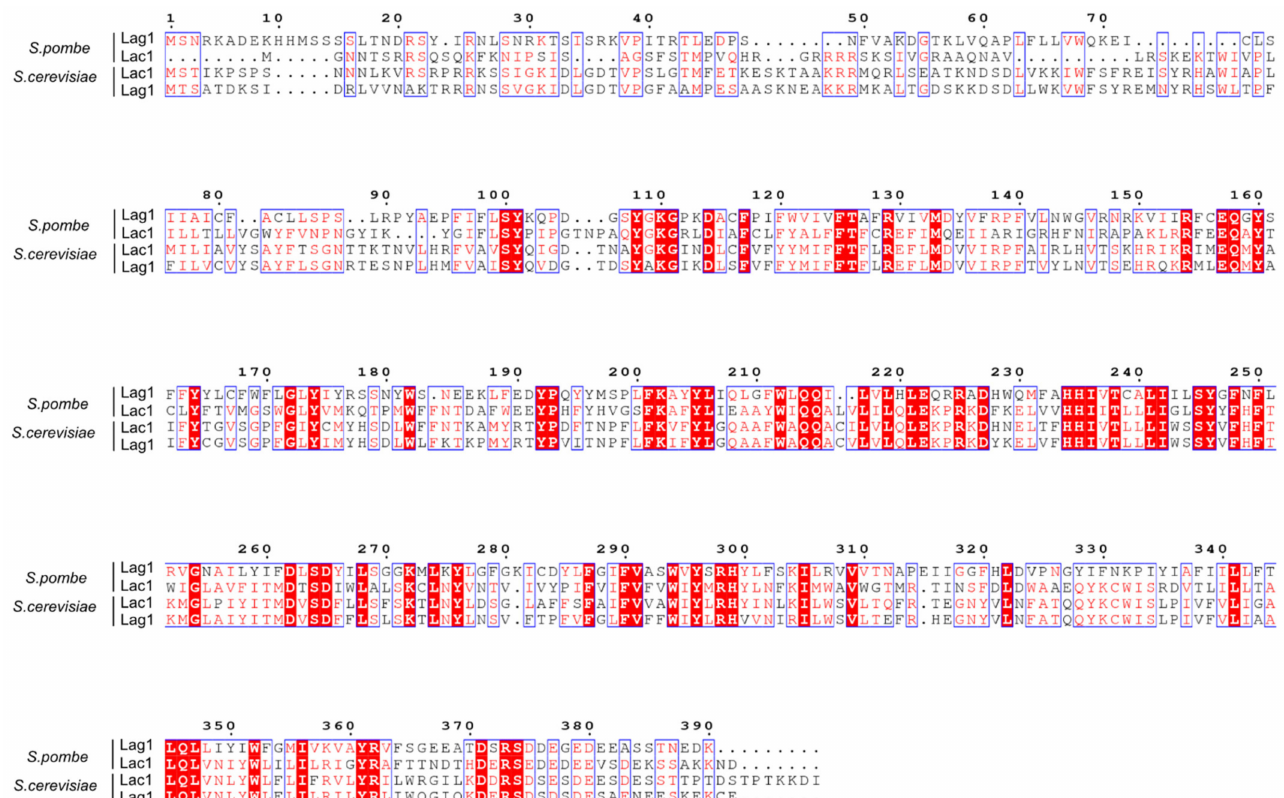
Figure 1. Multiple alignments of ceramide synthase subunits in fission and budding yeast. Sequence alignment was made for ceramide synthases from fission and budding yeast. White characters on red boxes denote identical residues, and red characters on white boxes denote conserved